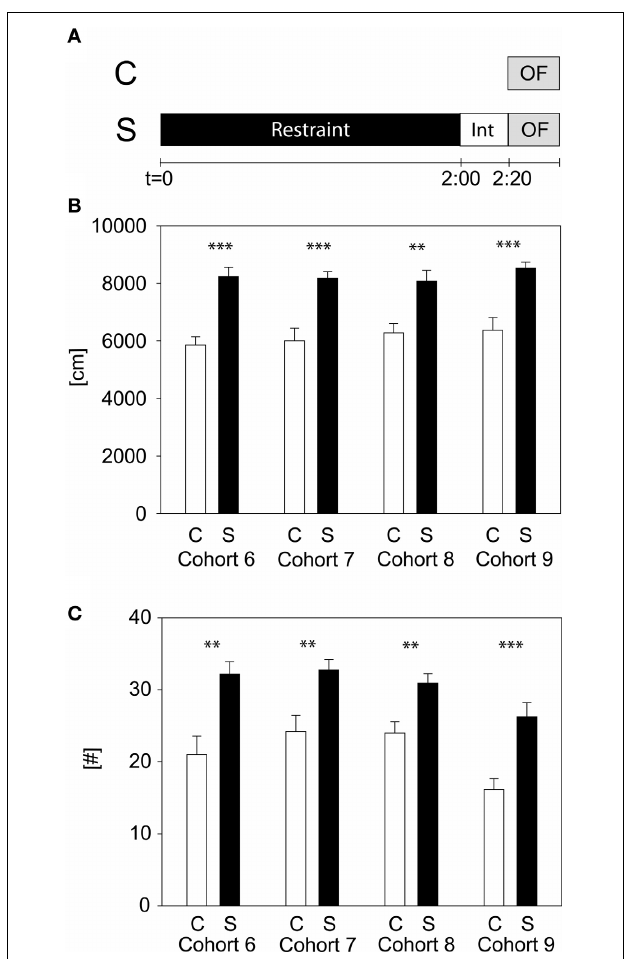
FIGURE 2 | Two hours acute stress in C57BL/6 males. Different cohorts of wildtype C57BL/6 strains were tested with the 2h acute stress protocol. Scheme of experimental design (A) . Depicted are the distance traveled (B) and the number of rearings (C) in the first 5min of the OF. Control groups, C, in white and stress groups, S, in black bars. Note that cohort 9 is of the C57BL/6N strain, whereas all the other cohorts are of the C57BL/6J strain. Int, interval; Error-bars shown as s.e.m.; significances: ∗∗ - p ≤ 0 . 01; ∗∗∗ - p ≤ 0 . 001 vs. C; n = 11–16 per group.